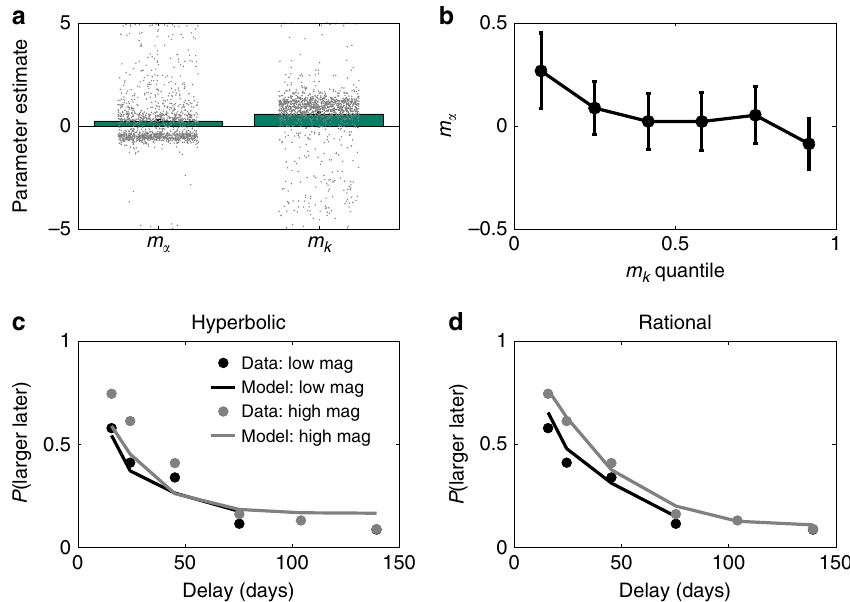
Fig. 3 Model fi t results. a Magnitude scaling parameter estimates for the three-parameter hyperbolic discounting model (H3). b The magnitude scaling parameter for choice stochasticity declines as a function of the magnitude scaling parameter for discounting. c Choice probabilities as a function of delay for low and high variance conditions, with theoretical functions obtained from the standard hyperbolic discounting model (H0). d Same as c , but with theoretical functions obtained from the rational-discounting model (R2). Data from ref. 22 , n = 1284 participants. Data are presented as mean values, dots denote individual participants, and error bars show 95% con fi dence intervals.